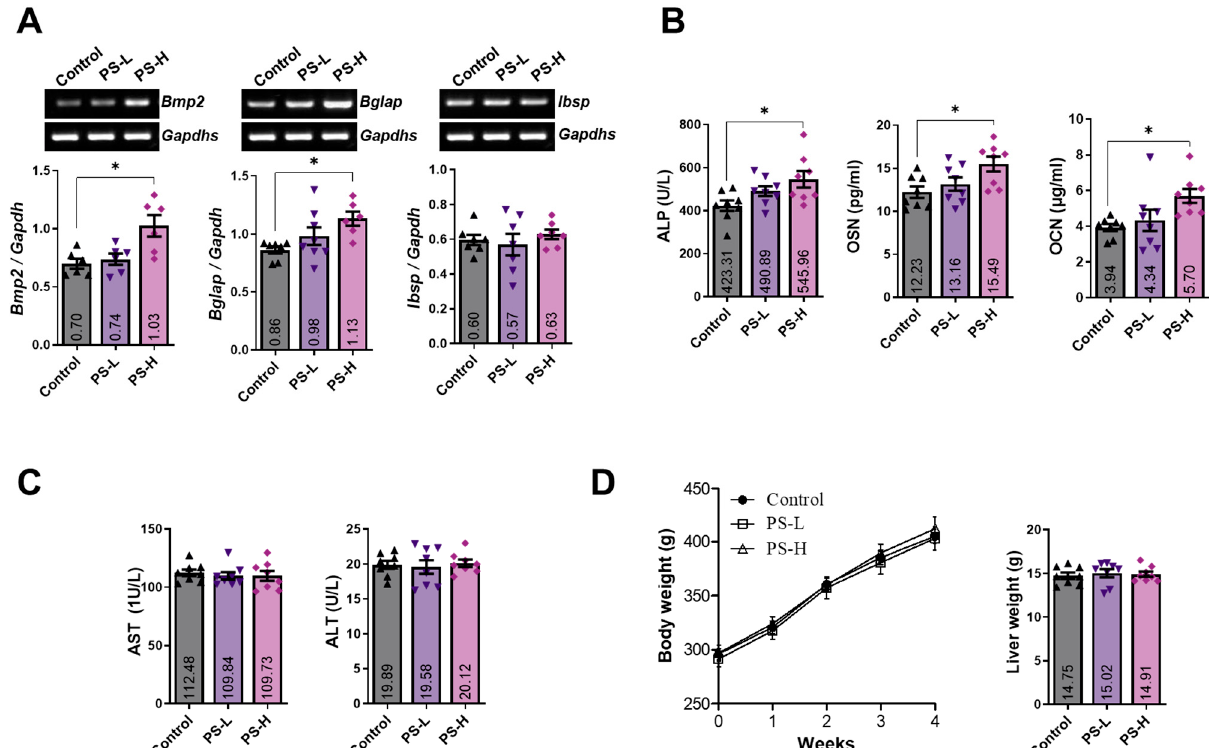
Figure 6. Effects of PS on the expression of osteogenic-related markers in whole blood and serum. Bone formation markers measured ( A ) in whole blood by RT-PCR, with the expression of each marker normalized with GAPDH, and ( B ) in serum by ELISA. ( C ) Hepatotoxicity index, AST/ALT, measured by ELISA. ( D ) Body weight change during weekly PS administration was measured, and the liver weight was measured after sacrifice. The shapes (triangles, squares, etc.) shown in each graph are values for each experimental rat. Data are expressed as mean ± SEM. * p < 0.05 versus control group.